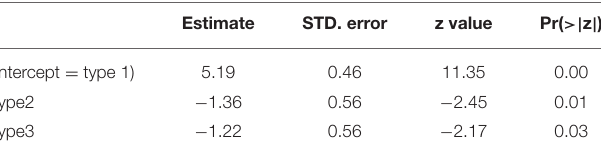
TABLE 3 | Logistic regression analysis of the accuracy of the judgements of the participants to words in experiment 1.